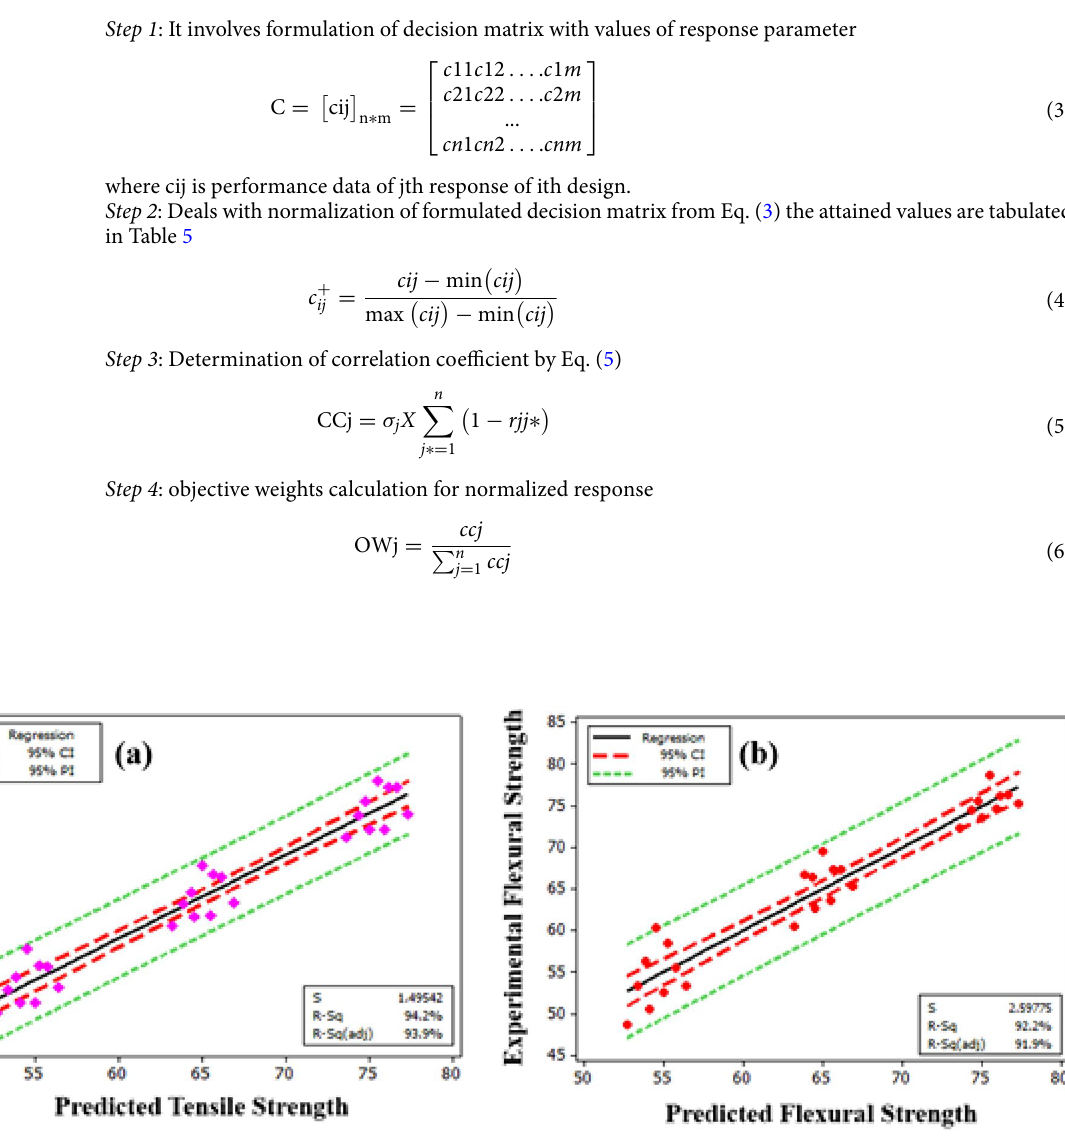
Figure 4. Fitted line plot between predicted and actual values ( a ) Tensile strength and ( b ) ultimate Flexural